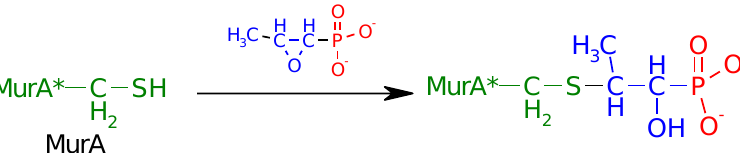
Figure 1. Mechanism of action of fosfomycin on the UDP-N-acetylglucosamine enolpyruvyl transferase enzyme